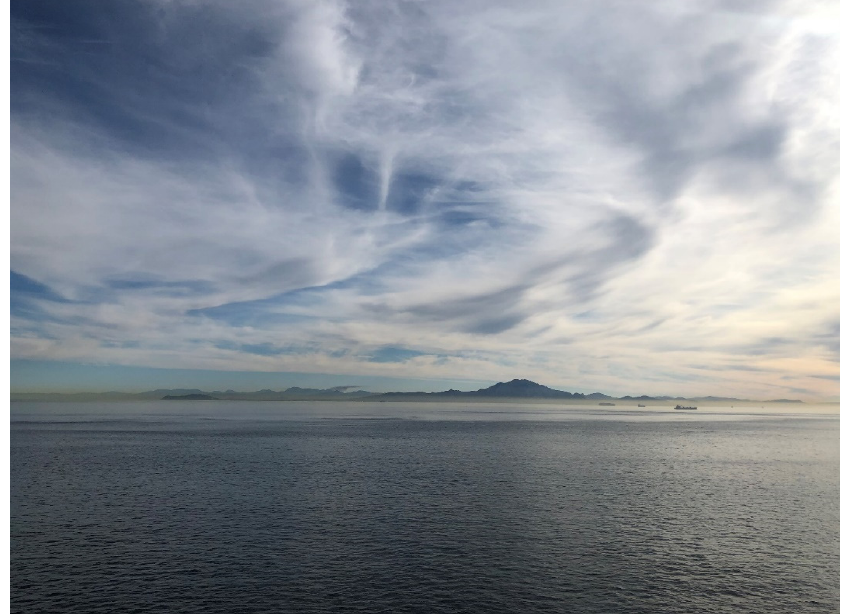
Figure 17. A view of North Africa from Europa Point, Gibraltar.